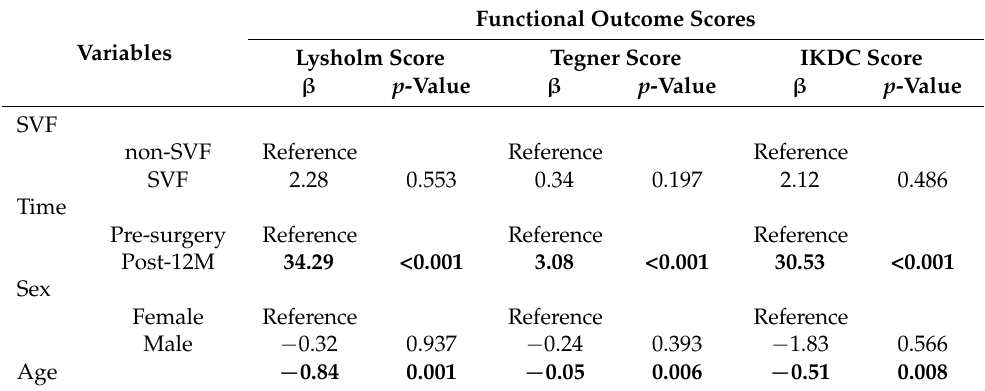
Table 3. Multivariate generalized estimating equations analysis of associations between variables and each type of functional outcome